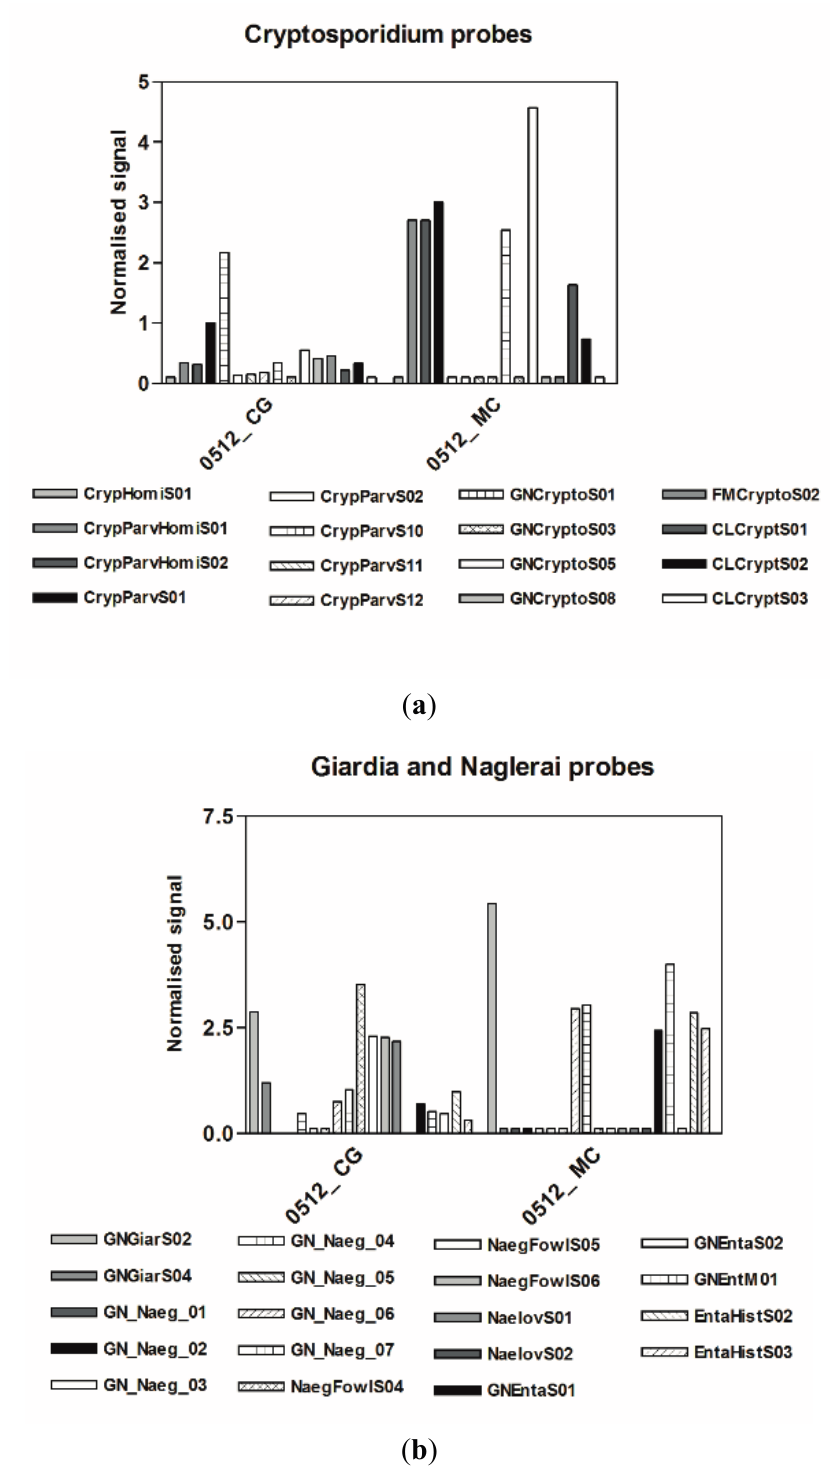
Figure 4. Protozoan probes of the Mezzocammino samples and Castel Giubileo samples. Signal intensities of each probe were normalized with the Dunaliella RNA 12.5 µM probe